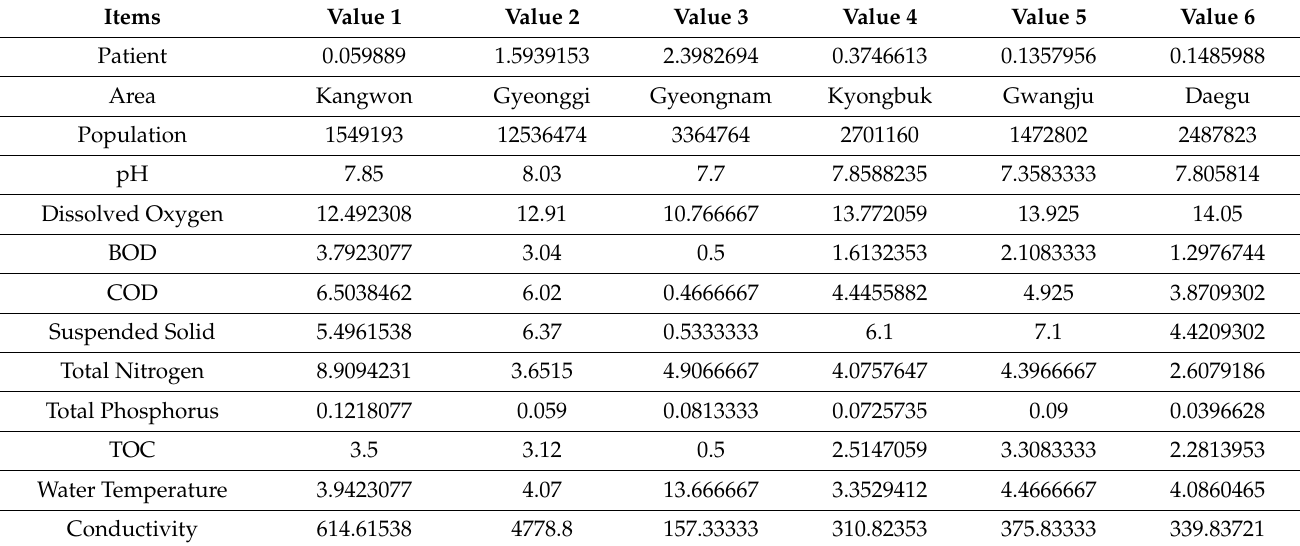
Table 6. Fifty integrated factors (patient information, region information, environmental factors).